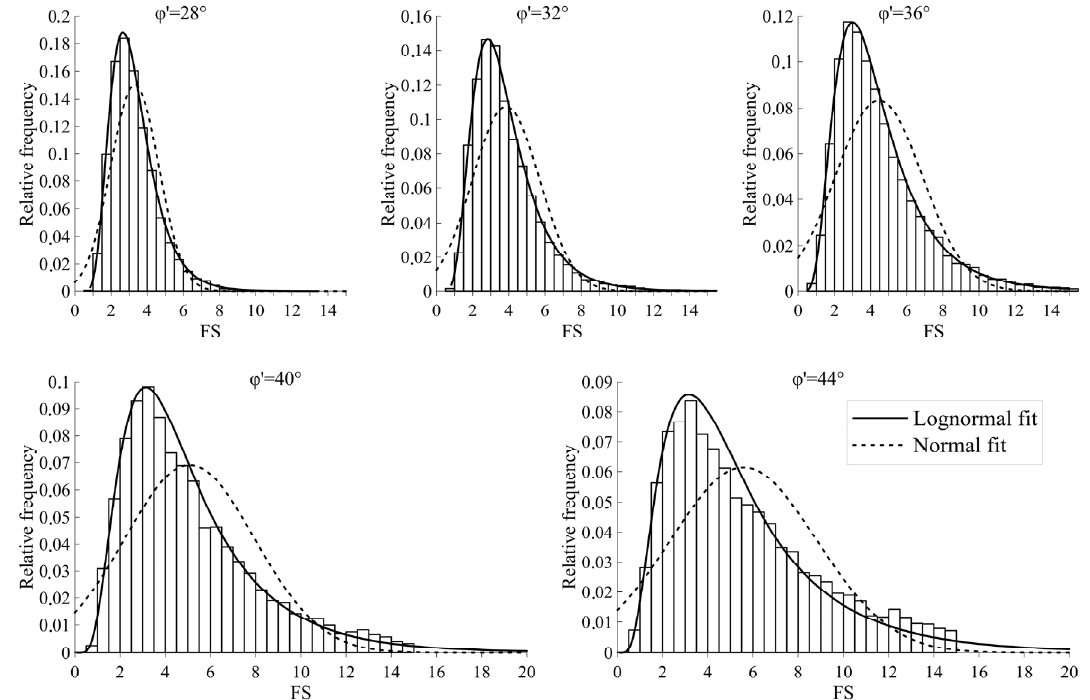
Figure 5. The factor of safety histograms for different φ (cid:48) , along with theoretical best-fit curves of normal and lognormal distribution.